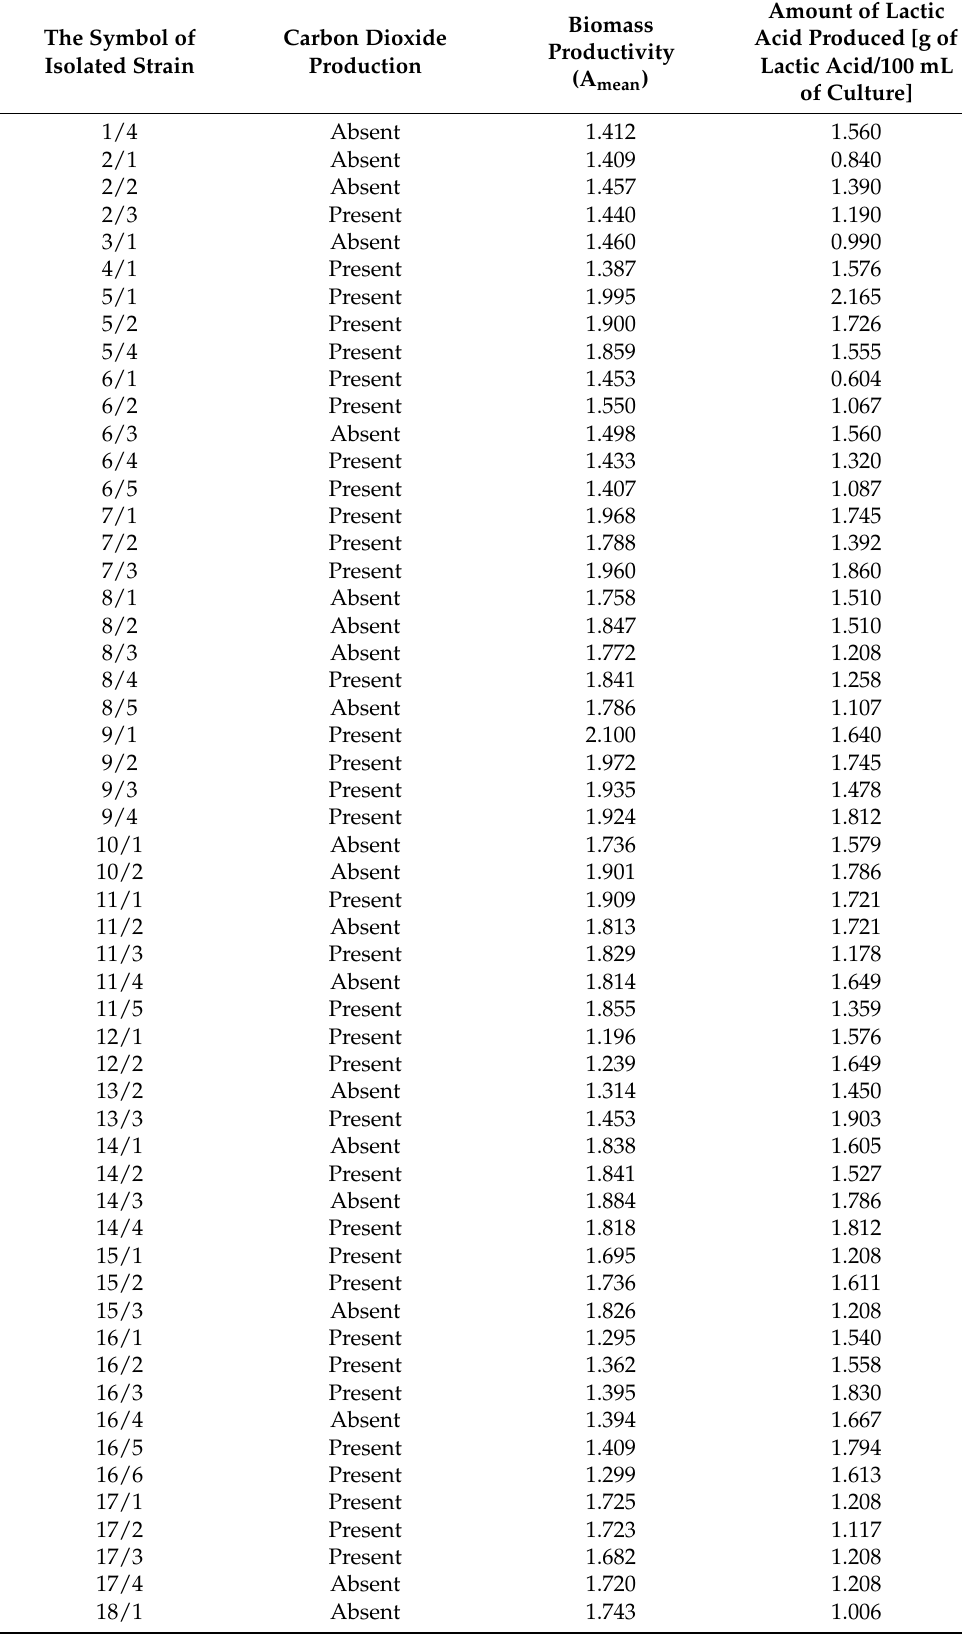
Table 4. The results of the characterization of lactic acid bacteria isolated from flowers and honeybee products in terms of their ability to produce carbon dioxide, biomass, and lactic acid. Amount of Lactic Biomass Acid Produced [g of The Symbol of Carbon Dioxide Productivity Lactic Acid/100 mL Isolated Strain Production (A mean ) of